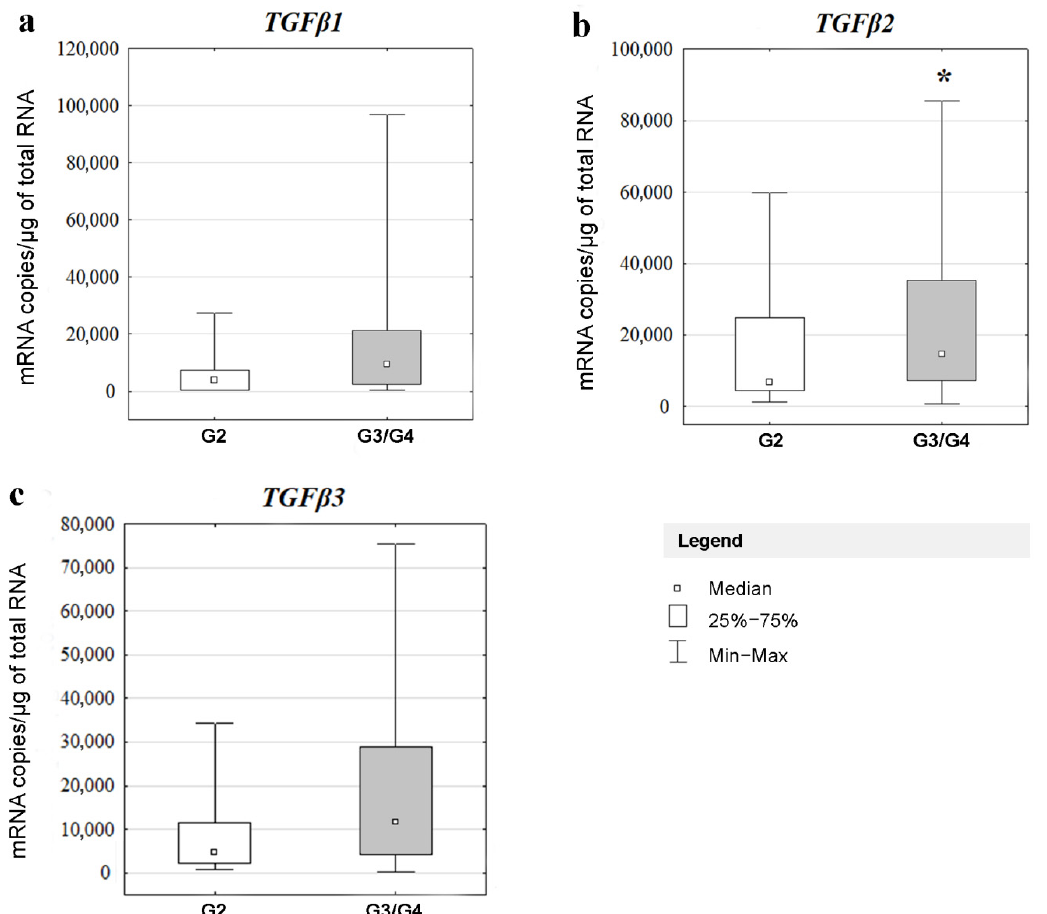
Figure 2. Expression of TGF β isoforms in gliomas with different grades of malignancy obtained by RT-qPCR. Results are presented as median with lower and upper quartiles and minimum and maximum values; G2, G3/G4—WHO grade of malignancy; *—statistical significance ( p < 0.05); ( a ) TGF β 1 ; ( b ) TGF β 2 and ( c ) TGF β 3 .